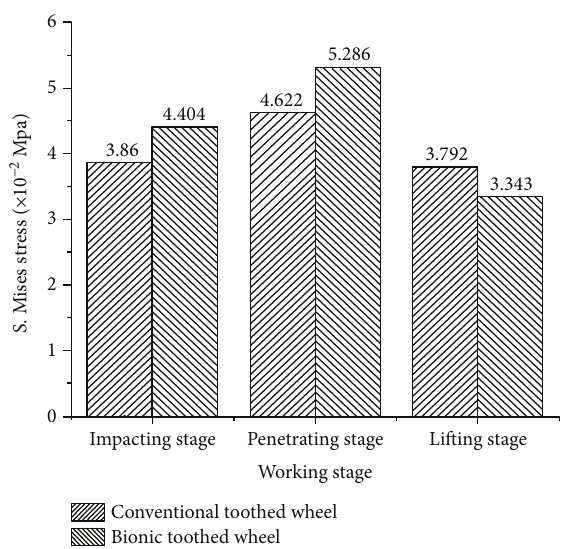
Figure 17: Maximum stress of conventional and bionic toothed wheel at the di ff erent working